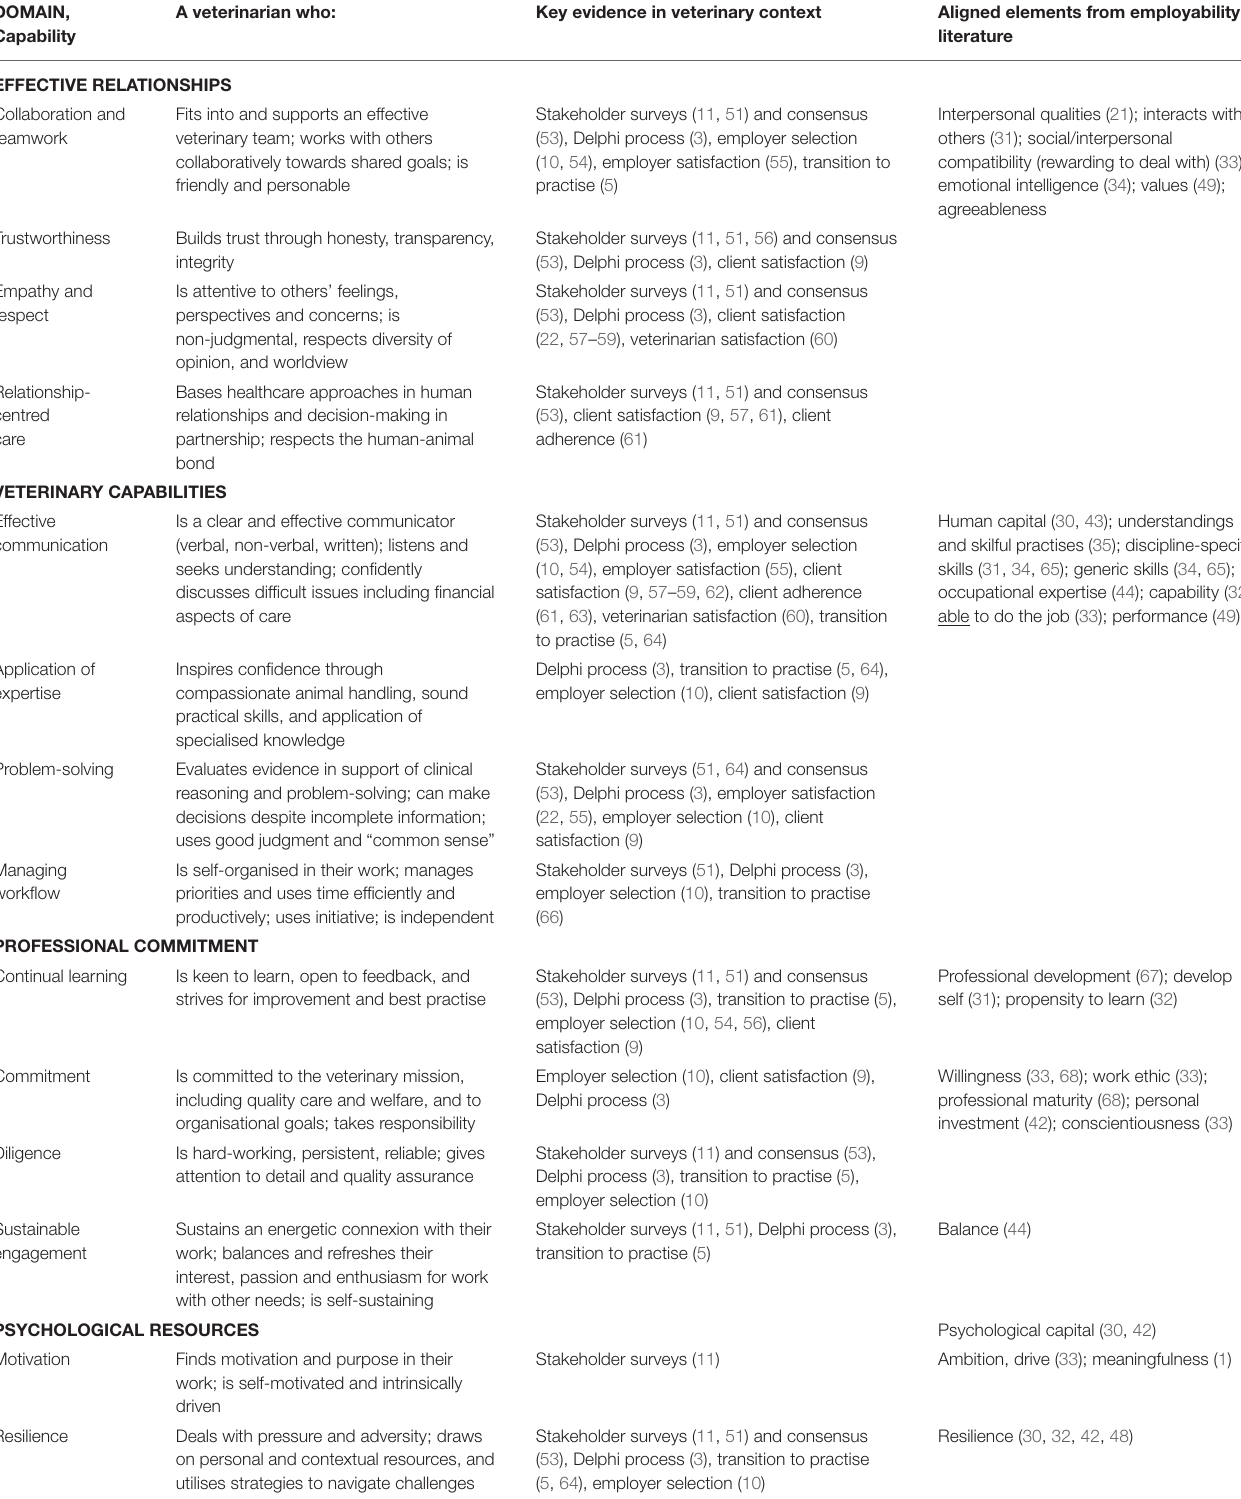
TABLE 1 | The 18 capabilities and five domains identified as consistently important to employability in the veterinary context, with exemplar descriptions, key published evidence from the veterinary literature, and aligned elements from the broader employability literature. DOMAIN,